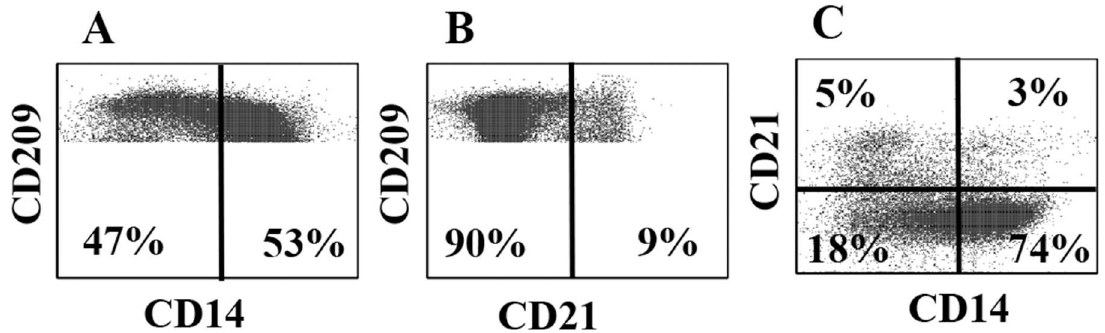
Fig 3. Three mAb comparison of co-expression of CD14 and CD21 on CD209 + bDC. A. Display showingthe proportionof CD14 + /CD209 + bDC with a selective gate on CD209 + bDC. B. The same display with the selective gate on CD209 + cells showingthe proportion of CD209 + cells co-expressing CD21. C. the same selective gate on CD209 + with a display comparing the proportions if CD21 + cells expressing only CD14 or CD21 or co-expressingCD14 and